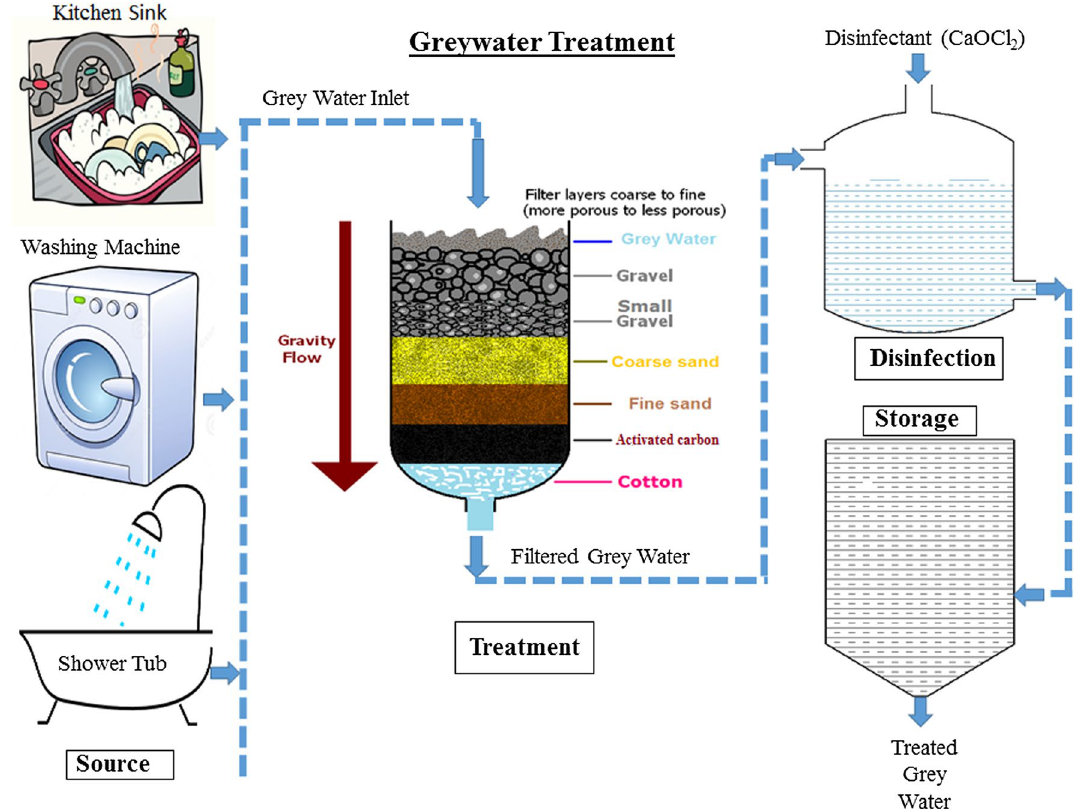
Fig. 2 Schematic diagram for the treatment of